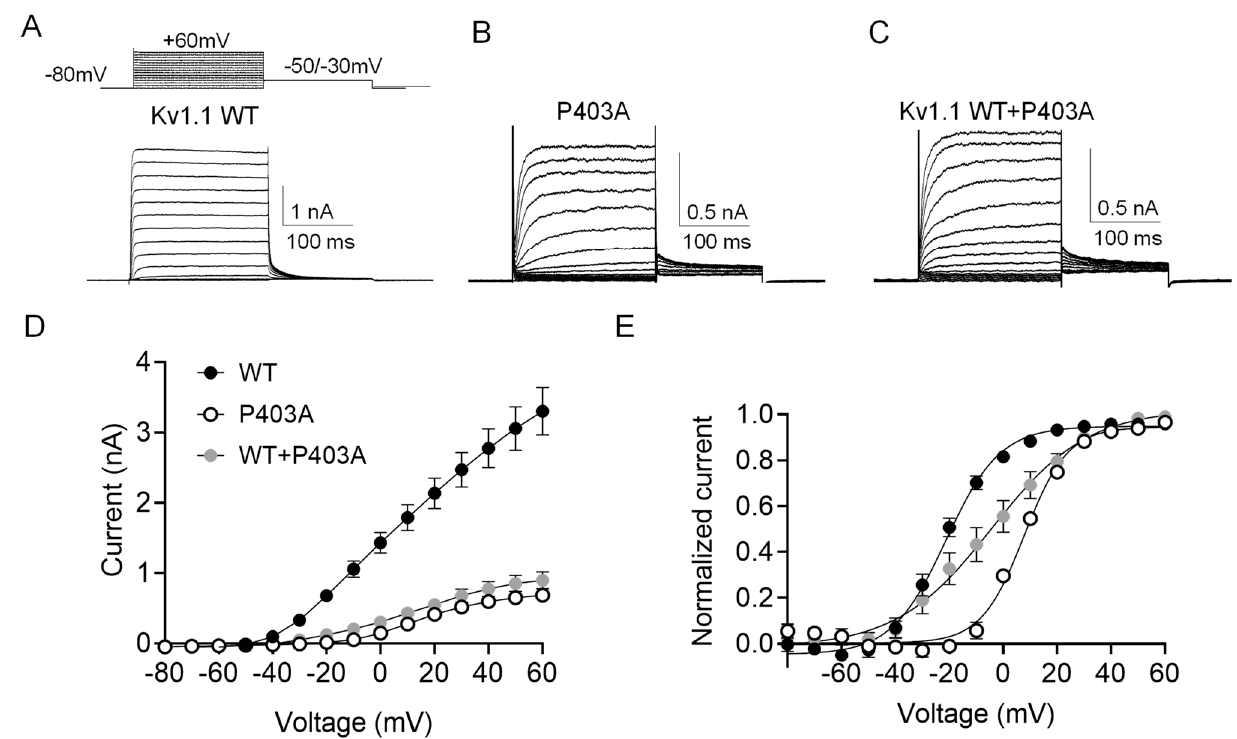
Figure 3. ( A – C ) Representative current traces evoked by 200 ms depolarizing steps from a holding potential of − 80 to +60 mV from Kv1.1 WT ( A ), P403A ( B ), and Kv1.1 WT+P403A ( C ) channels expressed in HEK 293 cells. The voltage protocol is indicated in the upper panel in ( A ). ( D ) Current– voltage relationship for Kv1.1 WT (5 μ g), P403A (5 μ g) and Kv1.1 WT+P403A (5 μ g + 5 μ g) channels (n = 14 − 36). ( E ) Voltage-dependent activation curves for Kv1.1 WT, P403A, and Kv1.1 WT+P403A channels were obtained by plotting the normalized peak tail currents measured at − 50 or − 30 mV as a function of the prepulse potentials and fitting data points with a Boltzmann function (n = 10 − 18 cells).